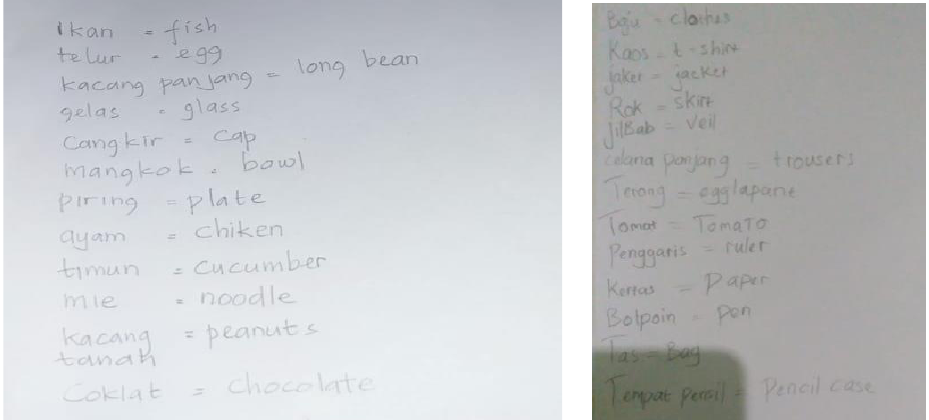
Figure 1. An object that memorized by